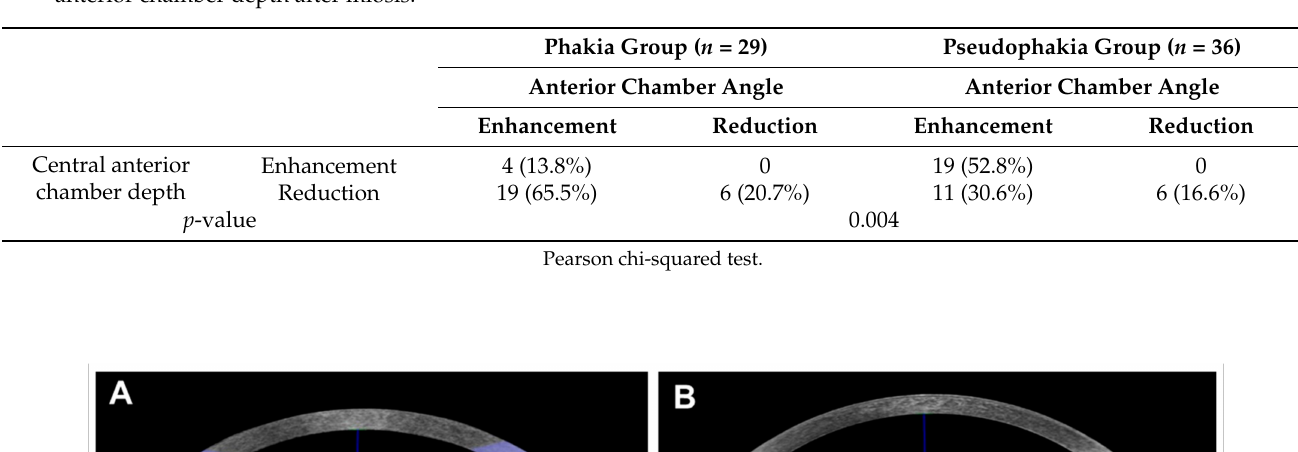
Table 4. Distribution of patients stratified according to the combination of changes in anterior chamber angle and central anterior chamber depth after miosis.